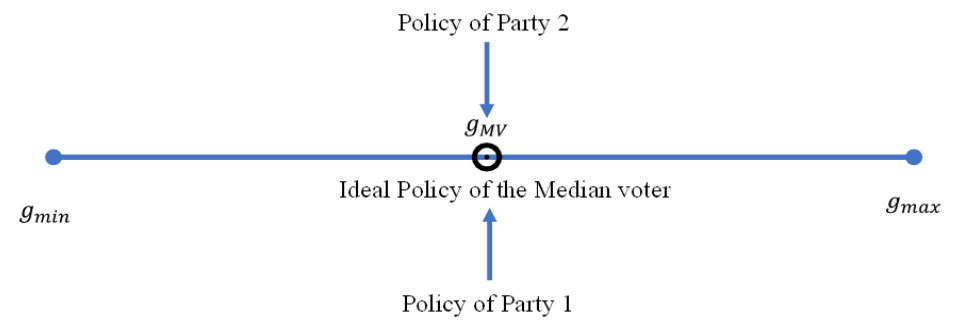
Figure 3. Prediction of models of electoral competition.